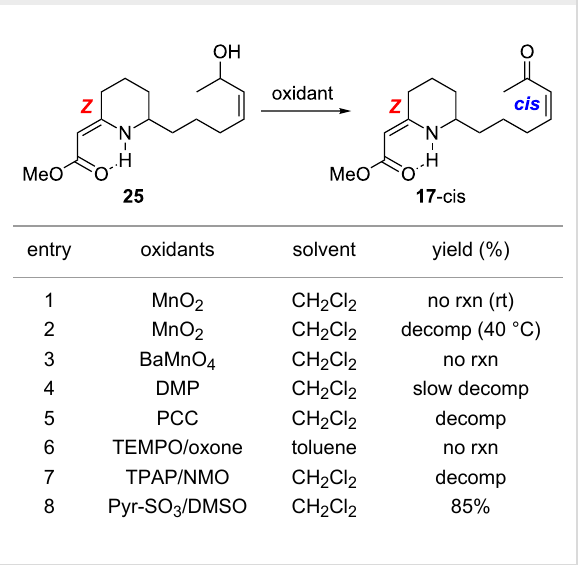
Table 2: Synthesis of the annulation precursor 17